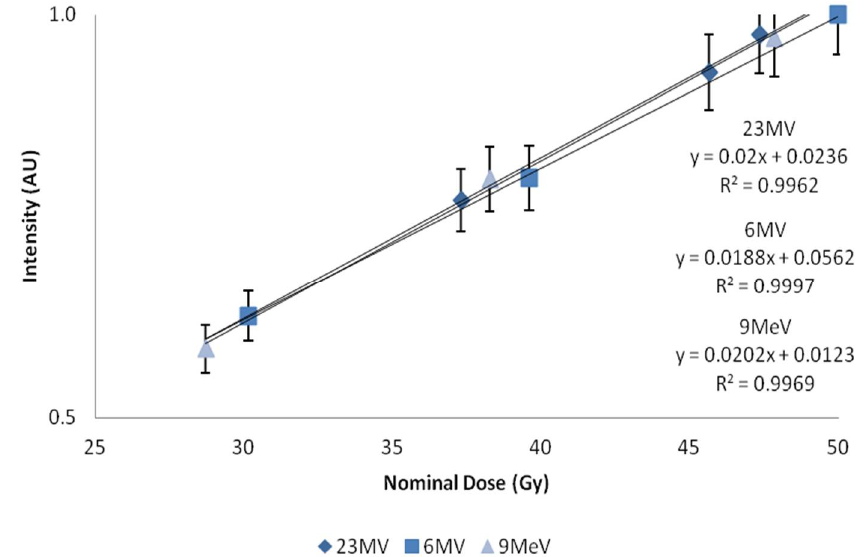
Figure 5. Nominal dose plotted against intensity. X -axis represents central axis dose for the depth of cuvette, and Y -axis the normalized fluorescent intensity. Error bars represent a 5% variation from the mean; calculated standard deviations from n = 4 samples per data point, less than 1%.